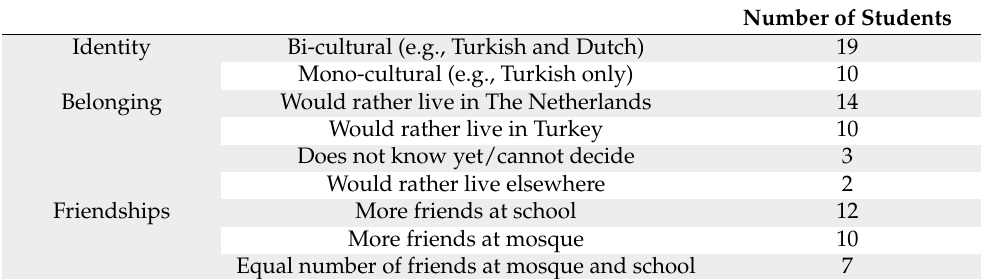
Table 3. Overview of student responses per conceptual